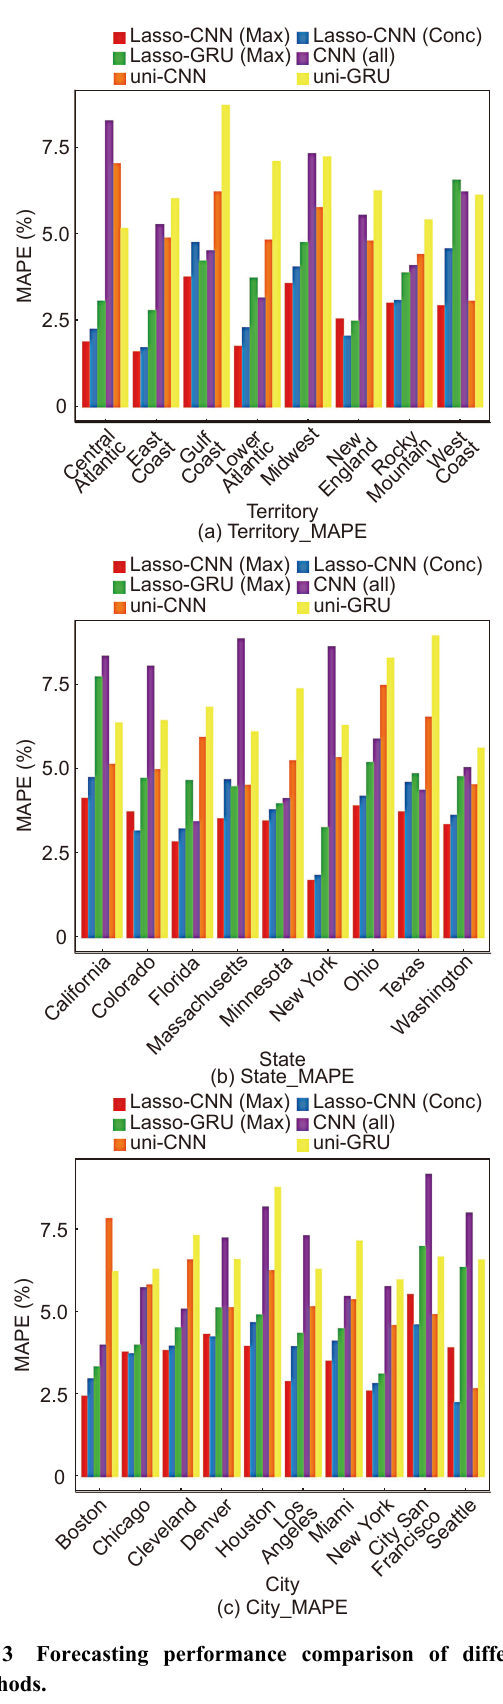
Fig. 3 Forecasting performance comparison of different